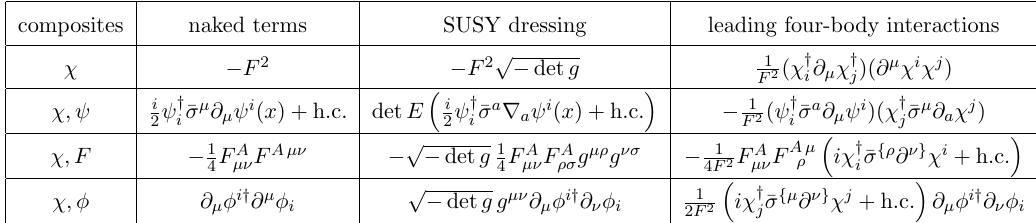
Table 1 . Model independent couplings for composite particles X = ; A (cid:22) ; (cid:30) . Partially composite particles have these couplings weighted by their degree of compositeness squared j (cid:15) X j 2 . If the scalar (cid:30) is a composite NGB one should dress the whole kinetic term built with the D -symbol D (cid:22) = @ (cid:22) (cid:30) i + O ( (cid:30) 3 i